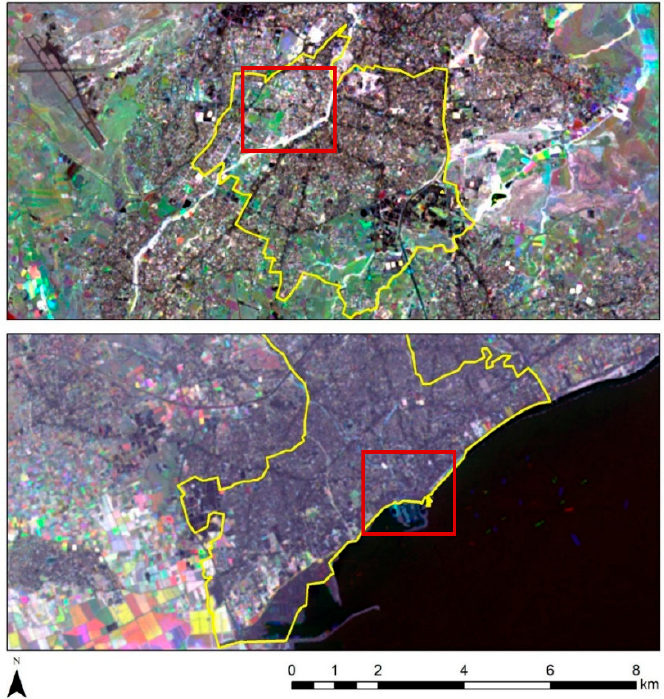
Figure 8. Pseudo-colour RGB composites from the NDVI annual maps, using 2013 (B), 2017 (G), and 2020 (R) as reference years. On top, the results for the Strovolos case study, and on the bottom the results from the Limassol case study.